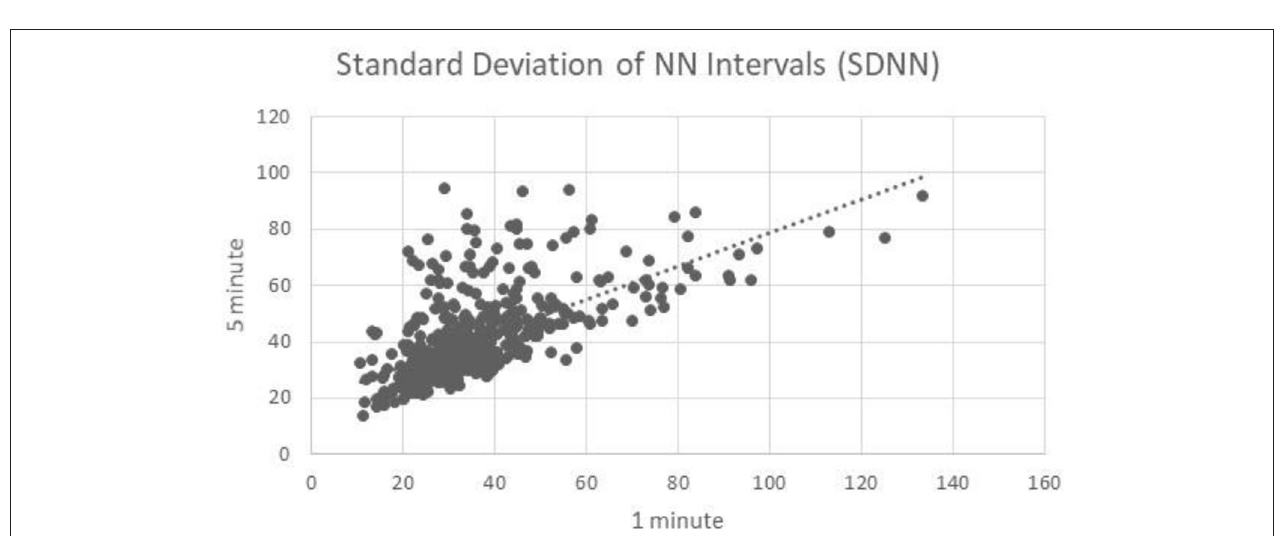
FIGURE 4 | Standard deviation of NN intervals